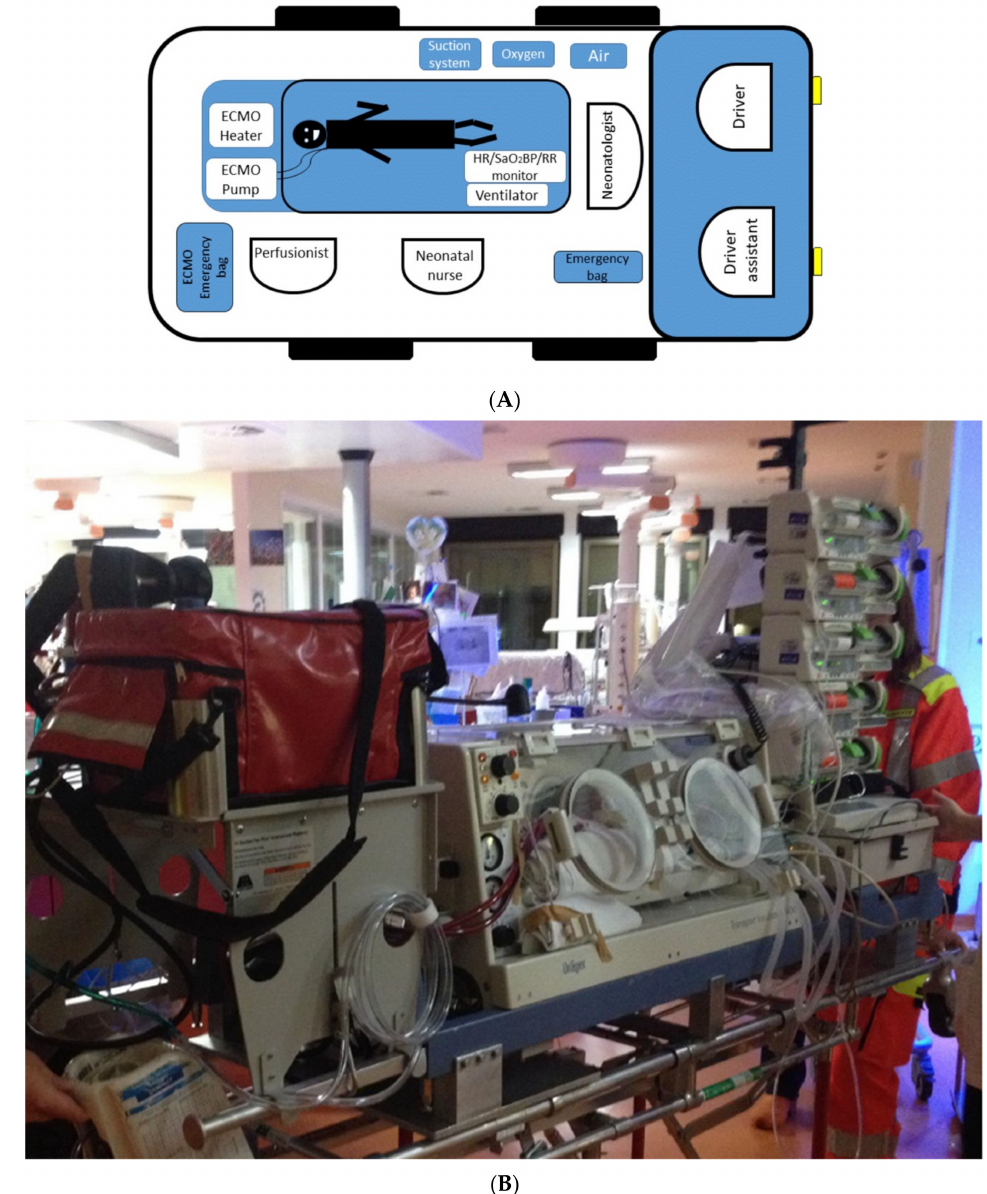
Figure 2. ( A ) Diagram showing allocation of the team members in relation to the patient and equipment positioning in the ambulance; ( B ) Picture showing our current